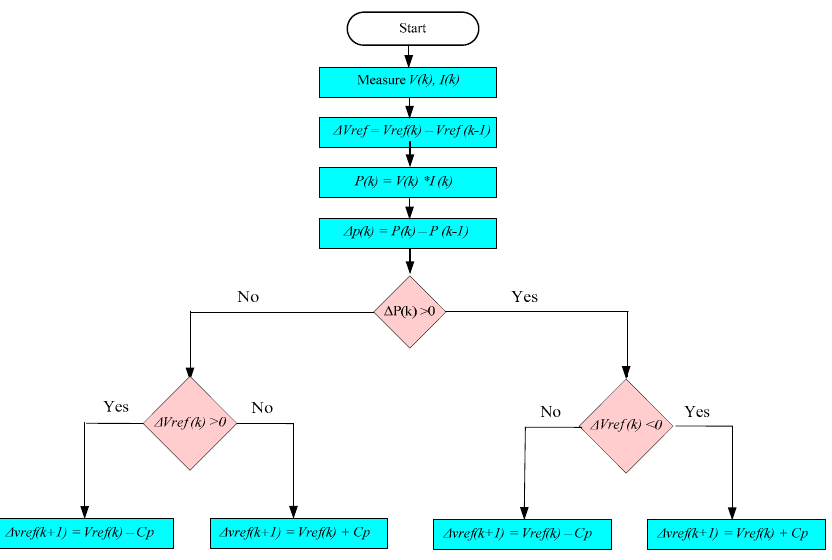
Figure 12. Flowchart of the P&O technique.